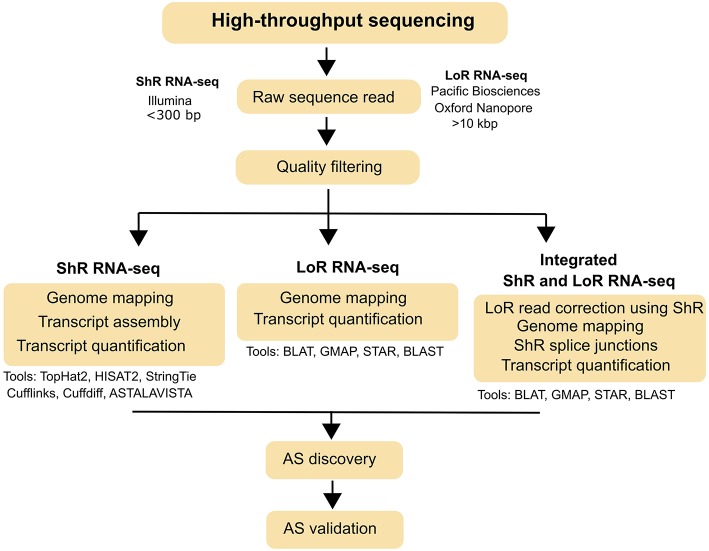
Typical workflow for AS identification from short read (ShR) and long read (LoR) RNA-seq. AS identification strategies using ShR and LoR RNA-seq and the various bioinformatics tools that can be used for each strategy are also indicated.